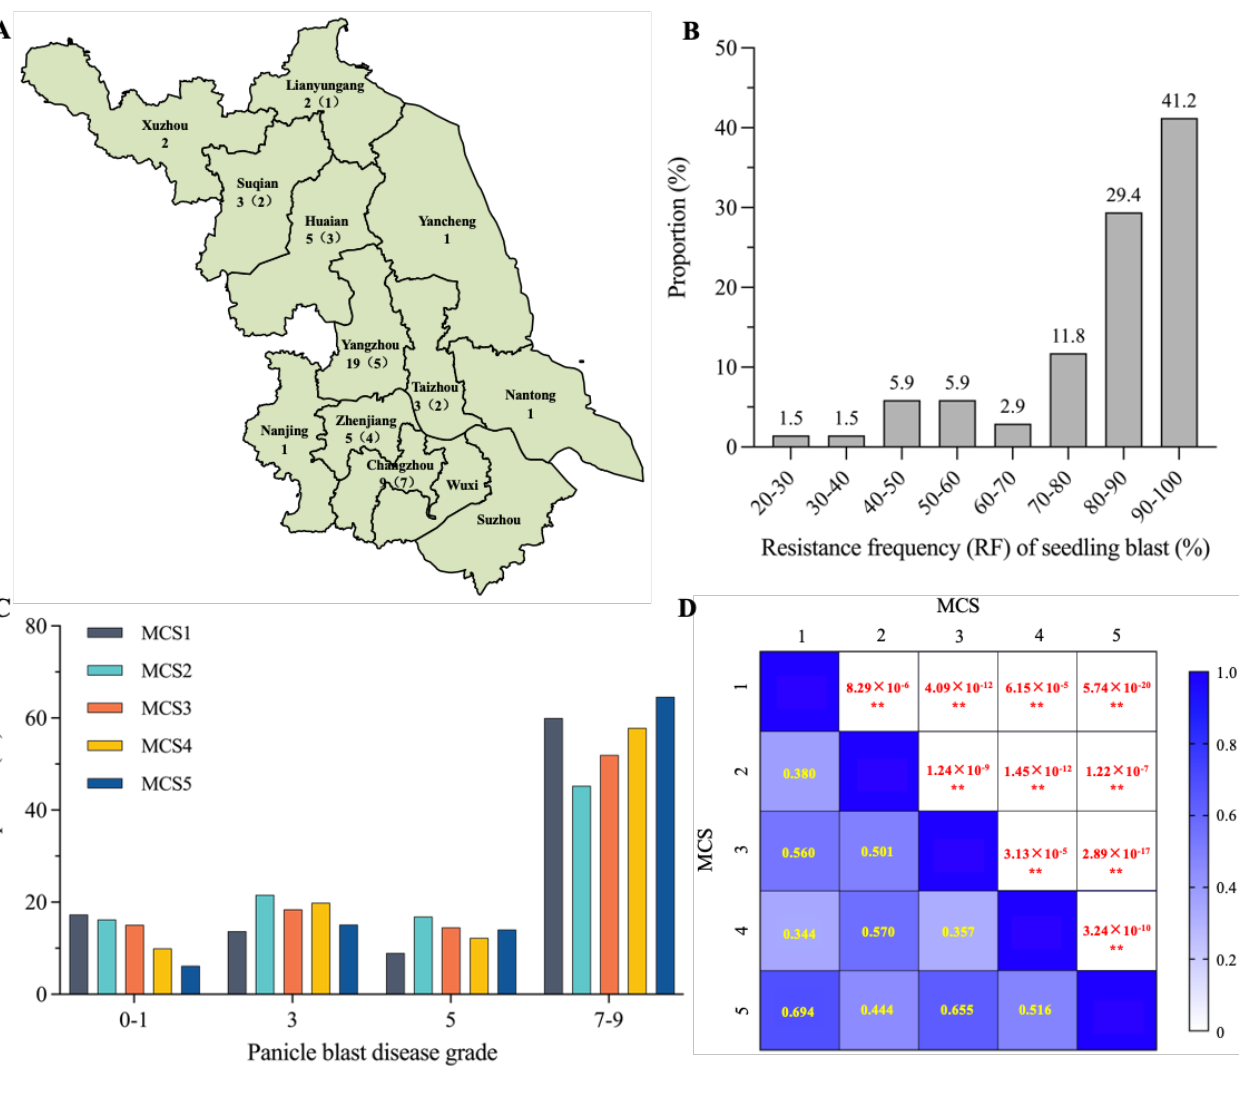
Figure 1. Evaluation of rice blast resistance of Geng rice varieties in the Jiangsu area. ( A ) Distribution of 58 M. oryzae isolates used for the artificial inoculation of rice blast in 11 prefectures of Jiangsu province. Numbers on the left denote the number of isolates used for seedling blast inoculation and numbers in parentheses on the right denote the number of isolates used for panicle blast inoculation. ( B ) Distribution of resistance frequency (RF) of seedling blast. The numbers above the columns denote the proportion of varieties with RF in the corresponding range. ( C ) Distribution of different panicle blast disease grades after inoculation with 5 groups of mixed conidial suspension (MCS). ( D ) Correlation of panicle blast disease grades with 5 groups of MCS. Yellow numbers denote the correlation coefficients of the 5 groups, and the red numbers denote the p -values. **: p < 0.01 by Student’s two-sided t-test.